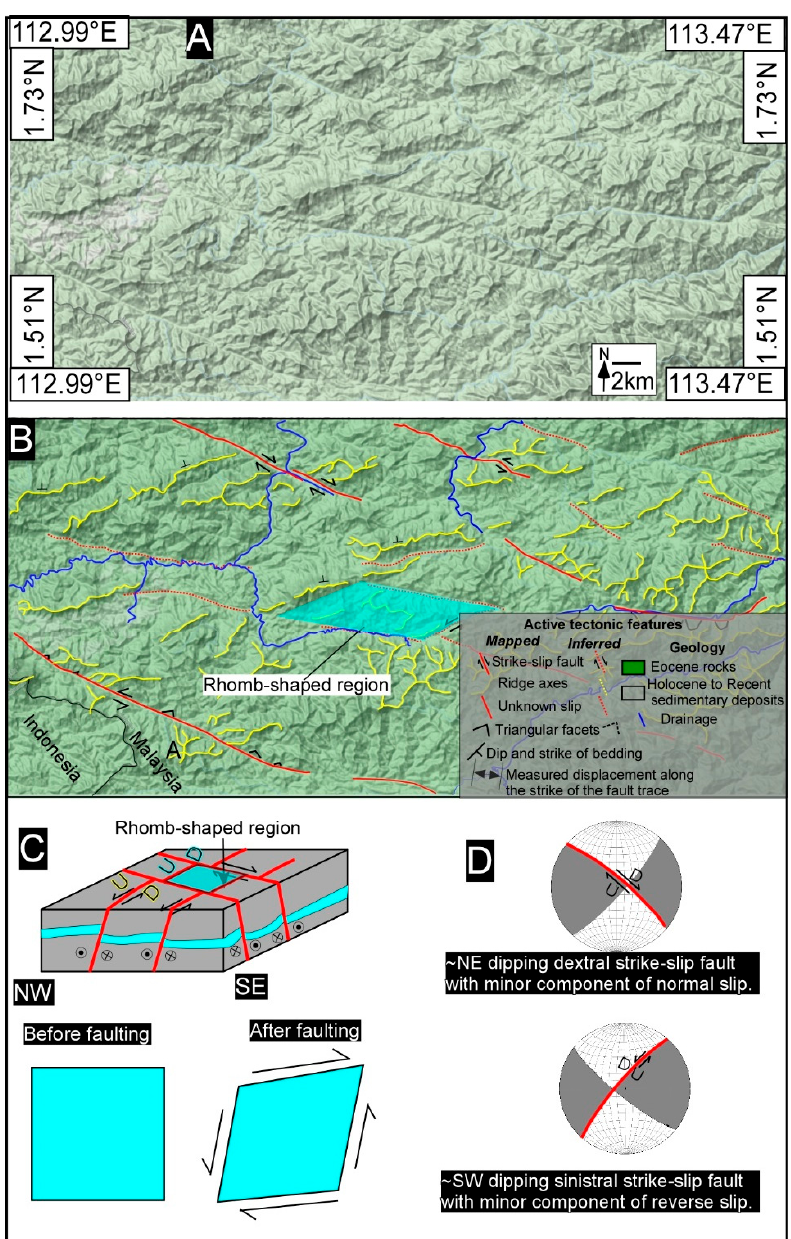
Figure 7. ( A ) Un-interpreted Google terrain image. ( B ) Evidence of not so well developed Rhomb-shaped landforms that are directly related to strike-slip faulting. The disrupted topography is clearly visible. ( C ) Cartoon shows the possible nature of faulting where dextral-strike slip faults have a component of normal dip-slip and sinistral faults have a component of reverse slip. Also shown are the expected earthquakes on these faults ( D ).